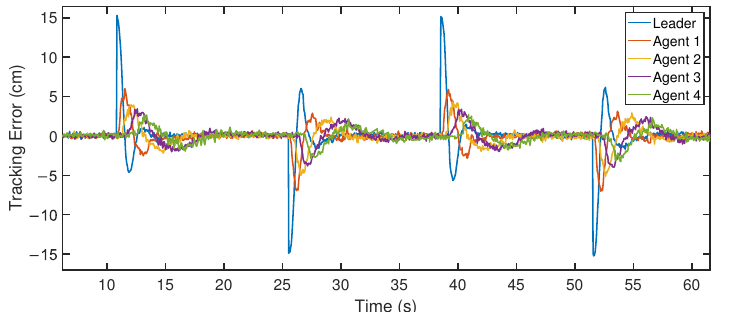
Figure 23. Results of the tracking error using the linear extrapolation strategy in the PL-TOON